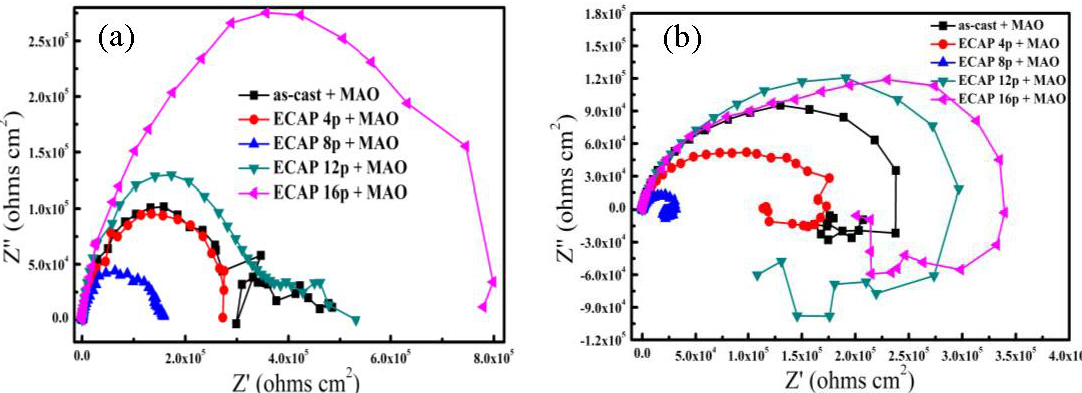
Figure 8. Nyquist plots of impedance spectra of the coated AZ91D samples immersed in 3.5 mass % NaCl solutions for ( a ) 30 min and ( b ) 1 day.